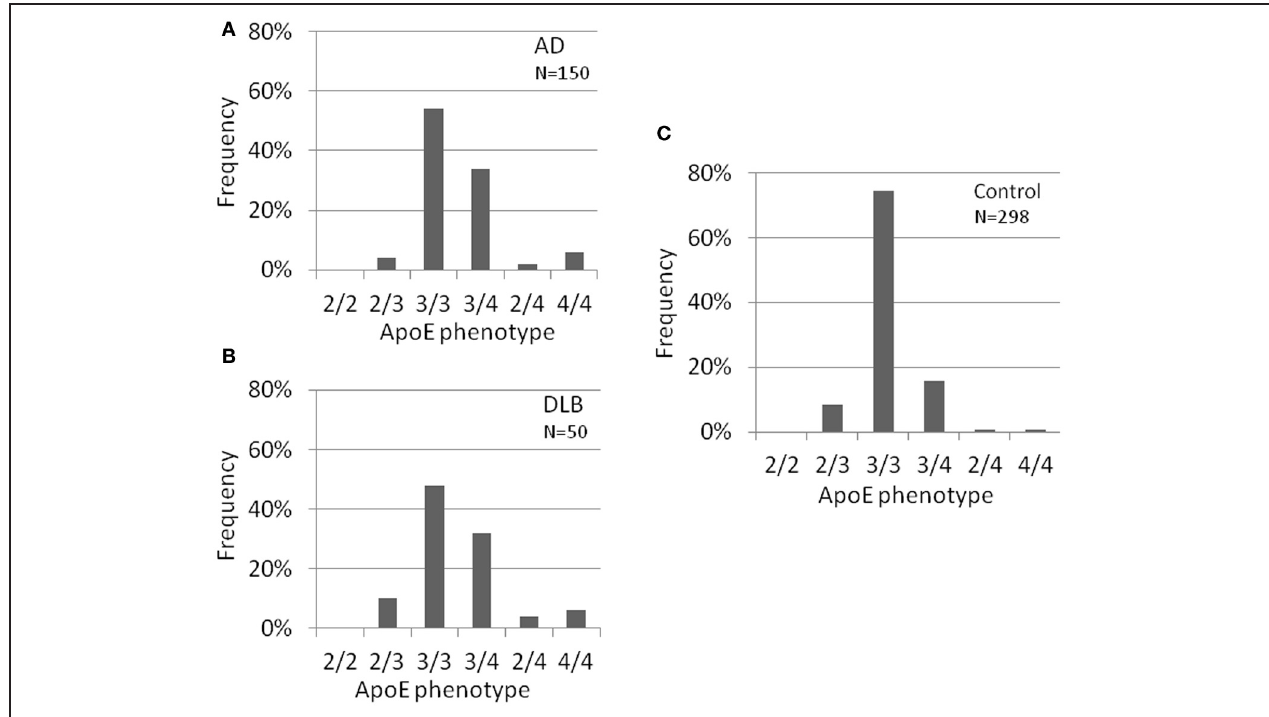
FIGURE 3 | ApoE carrier statuses of AD (A), DLB (B), and healthy volunteers (control) (C). ApoE carrier statuses are significantly different between AD and control, and between DLB and control. However, no